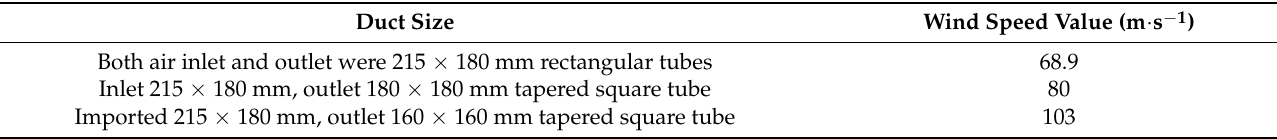
Table 8. Wind speed